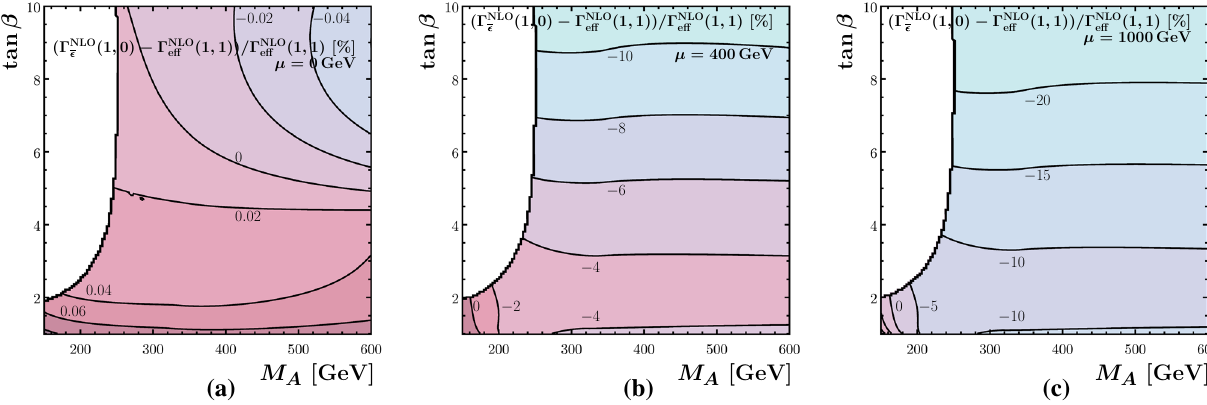
( 1 , 1 ) as a function of M β for a μ = 0GeV, b μ = 400GeV and c μ = A in GeV and tan eff